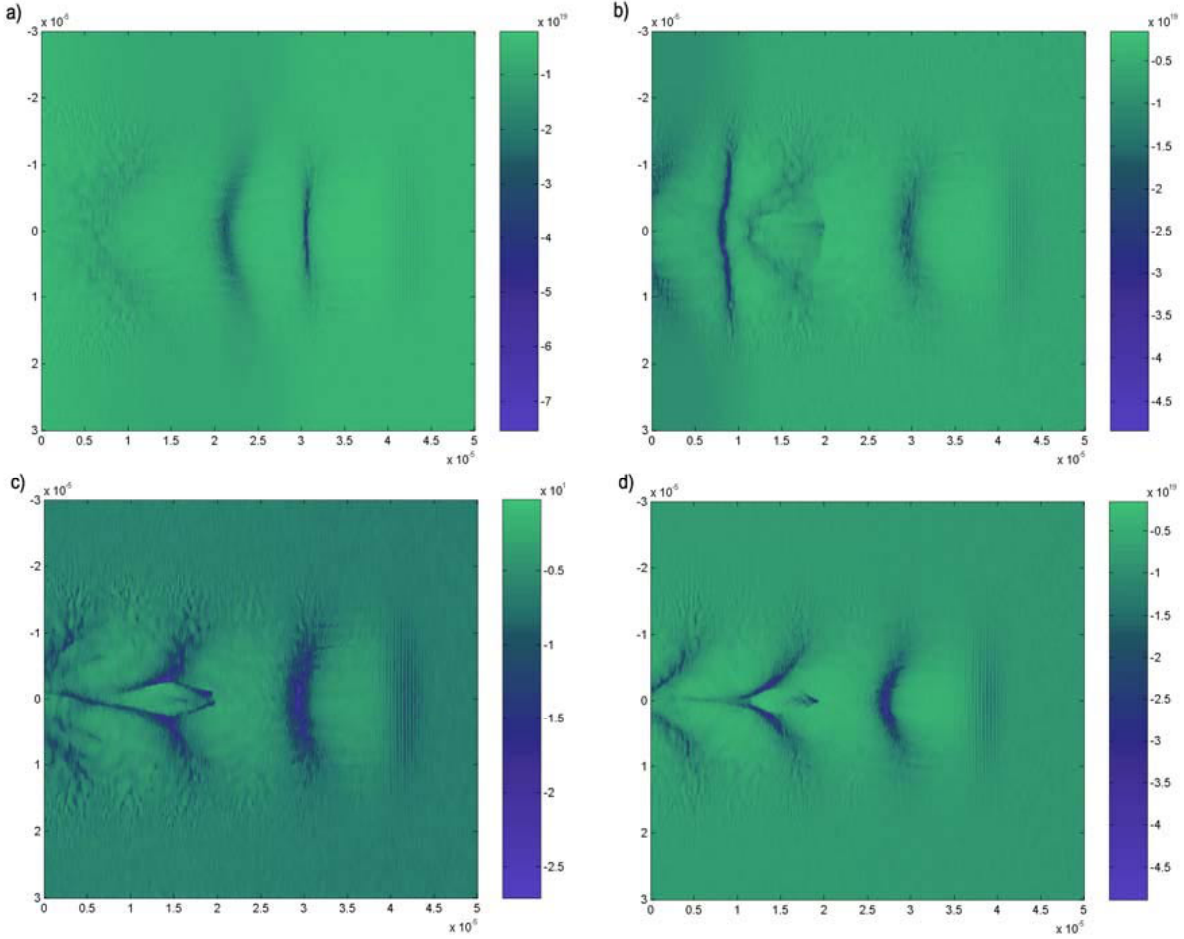
FIG. 4. (Color) Snapshot of the electronic density when the laser pulse is in the first plateau (a), the laser pulse is crossing the transition (b), the laser pulse is just in the accelerating region (c), and the laser pulse has propagated for about 200 (cid:4) m in the accelerating region